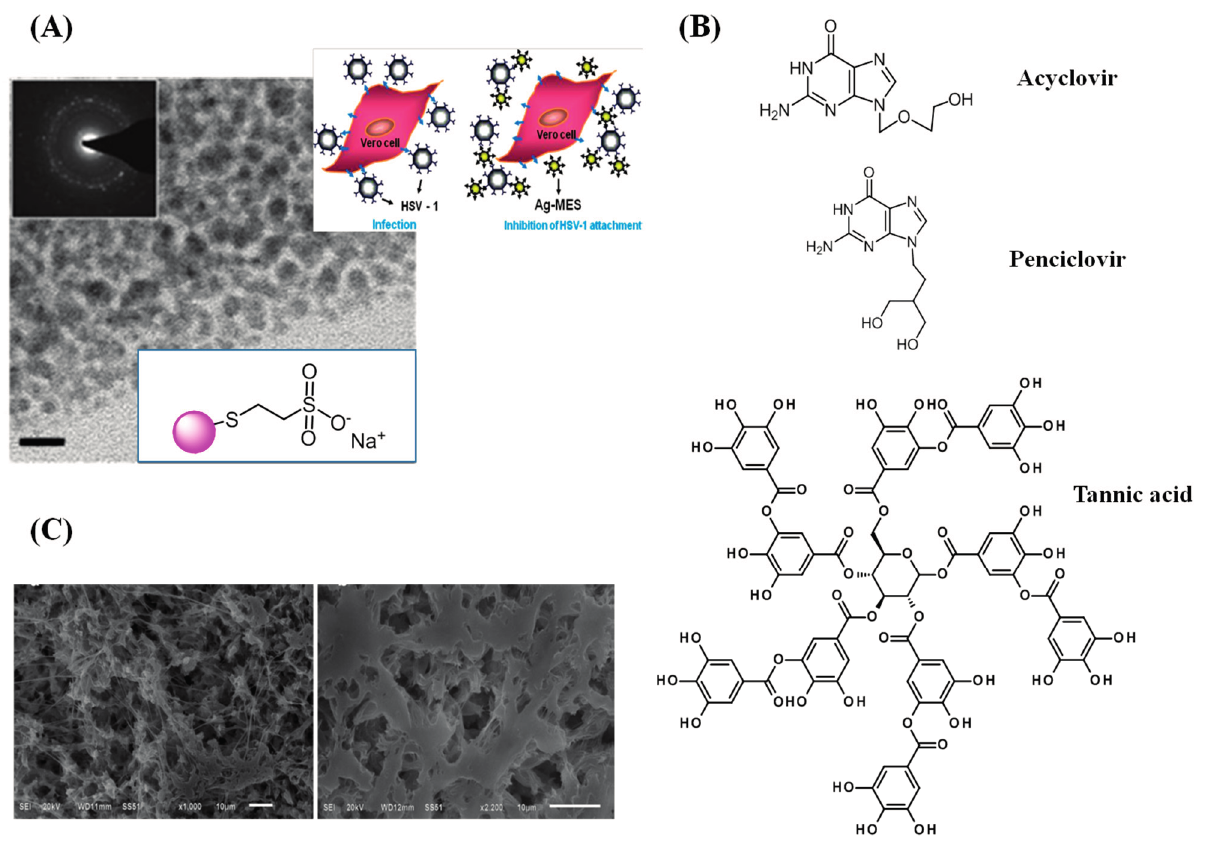
Figure 10. ( A ) Mercaptoethane sulfate-modified Ag NPs together with TEM image and mode of inhibition (reprint with permission from Ref. [108]); ( B ) Chemical structures of anti-herpes drugs acyclovir, penciclovir, and tannic acid; ( C ) Microporous polycaprolactone matrix loaded with 7% acyclovir for controlled delivery of antiviral agents (repring permission from Ref.